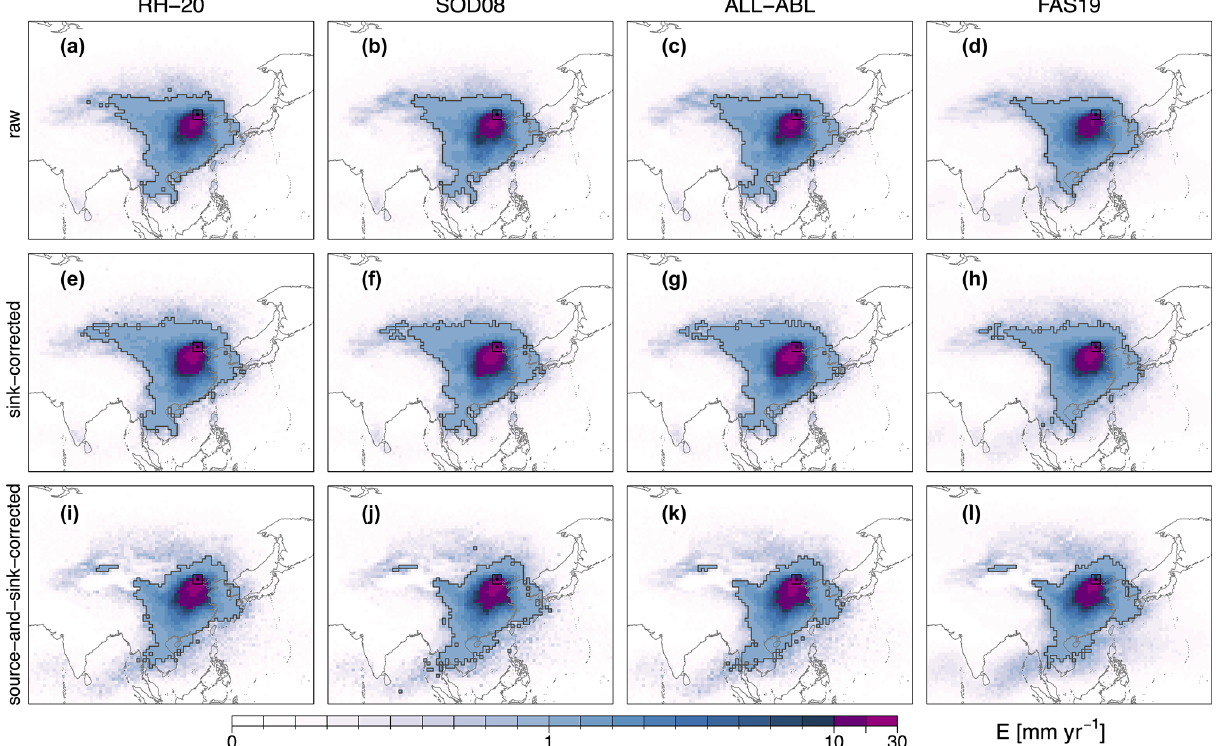
Figure 9. Same as Fig. 8 but applying the random attribution method. Note that the color scale is